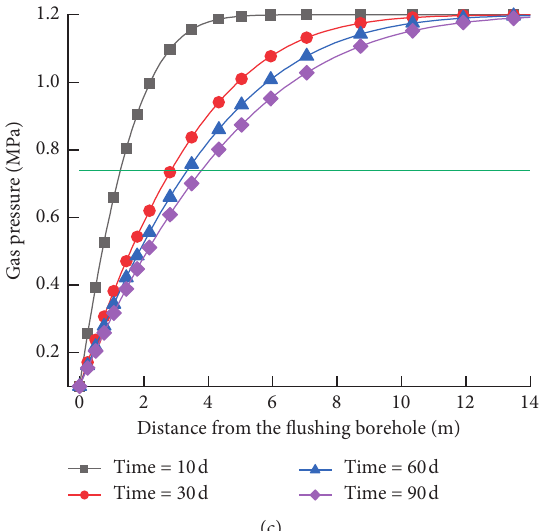
Figure 12: Gas pressure distribution curve with different coal outputs for different periods. (a) Coal outputs � 0.5t/m, (b) coal out- puts � 1.0t/m, and (c) coal outputs �